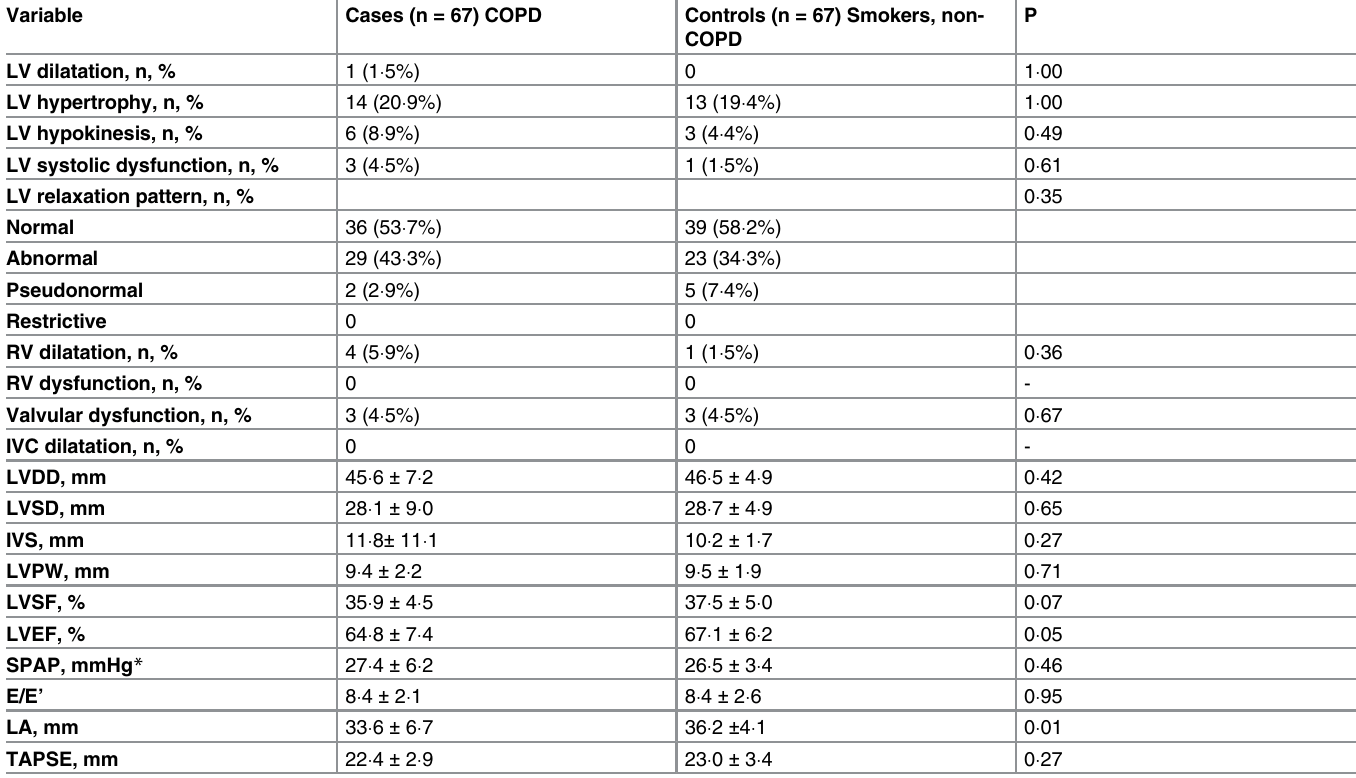
Table 5. Echocardiography results.